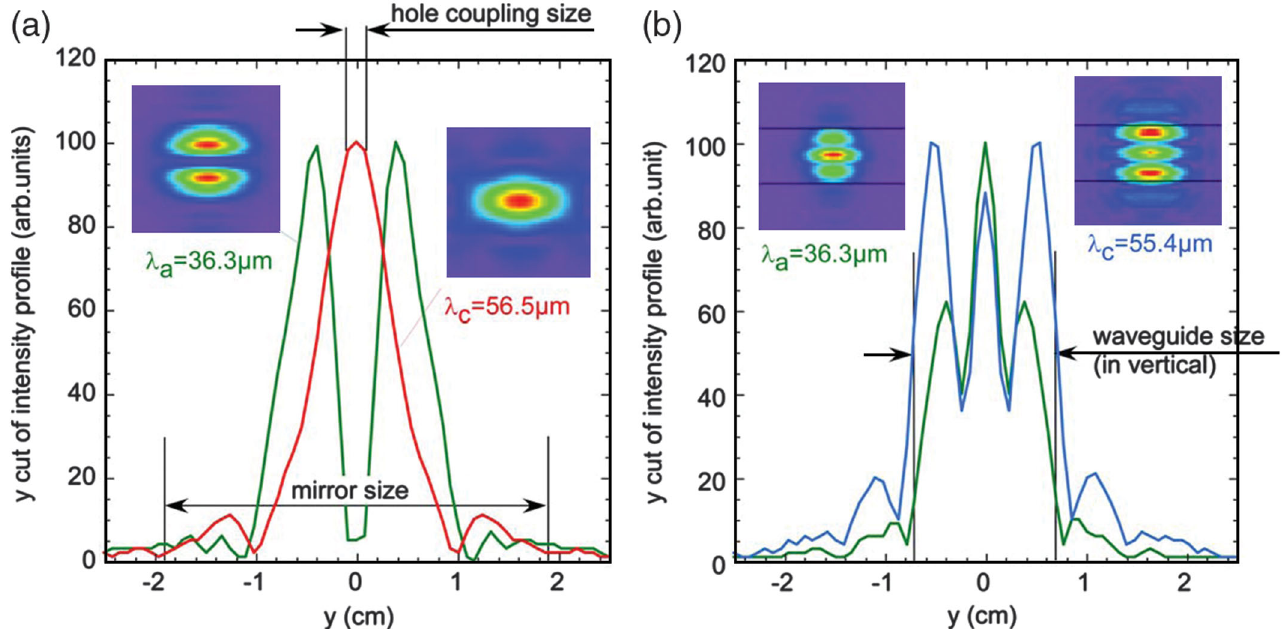
FIG. 9. (Color) (a) Numerical simulation in the case of toroidal cavity: laser mode transverse profiles on the output mirror, for two different wavelengths. (b) Numerical simulation in the case of toroidal cavity: laser mode transverse profiles on downstream waveguide entrance, for two different wavelengths.